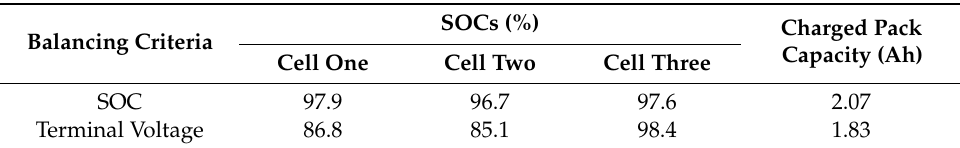
Table 3. Performance comparison of active balancing approaches based on SOC and terminal voltage as balancing